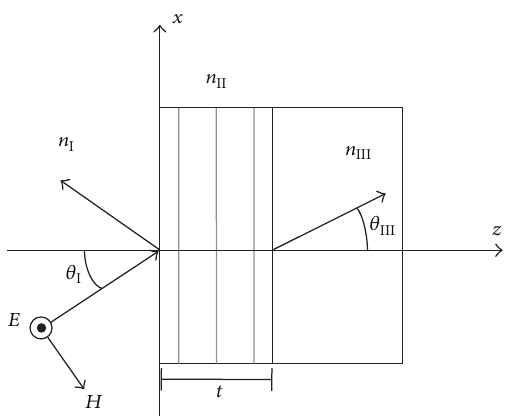
Figure 1: Diffraction reflection